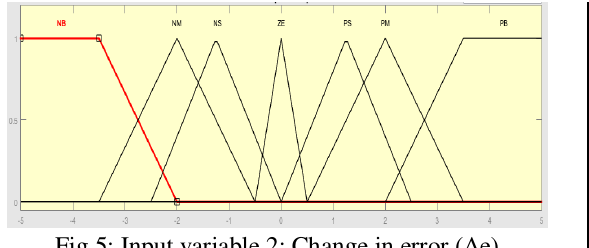
Fig.5: Input variable 2: Change in error ( Δ e) membership functions